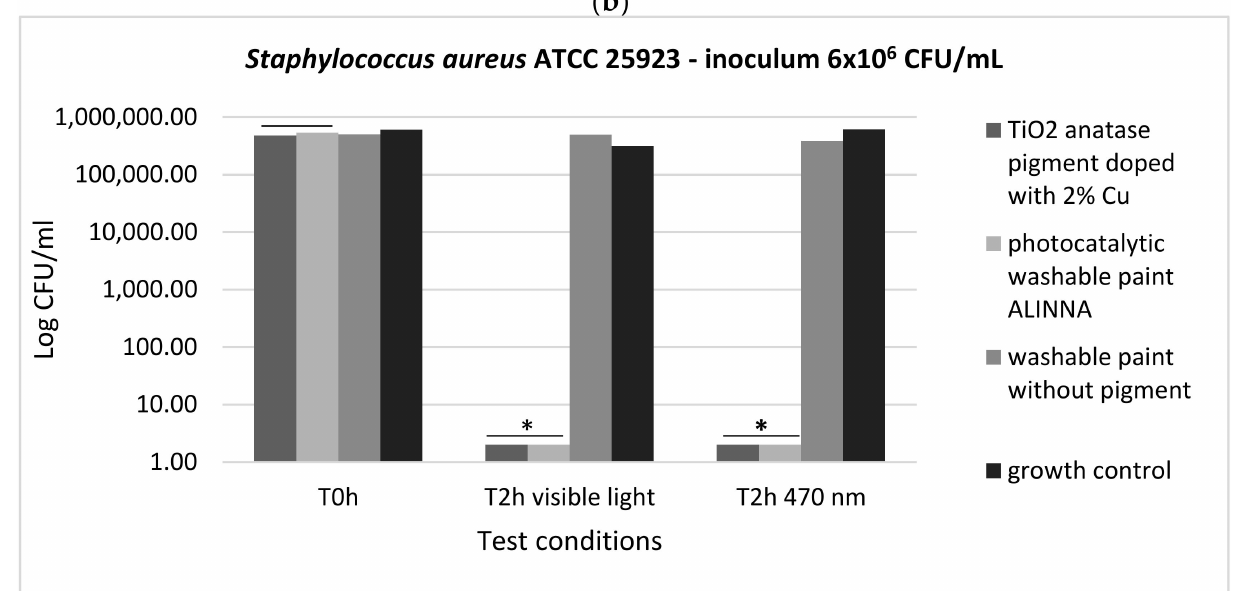
Figure 17. Graphical representation of the log10 values of colony-forming units (CFU)/mL representing the viable cells of S. aureus ATCC 25922 after the 2 h contact with tested products, in two conditions: blue light (470 nm) and visible light; ( a ) 1.5 × 10 6 CFU/mL tested bacterial cell density; ( b ) 6 × 10 6 CFU/mL tested bacterial cell density; * 0.05 ≥ p (T ≤ t) > 0.001 shows significant evidence of inhibitory effect manifested by doped pigment on bacterial growth and